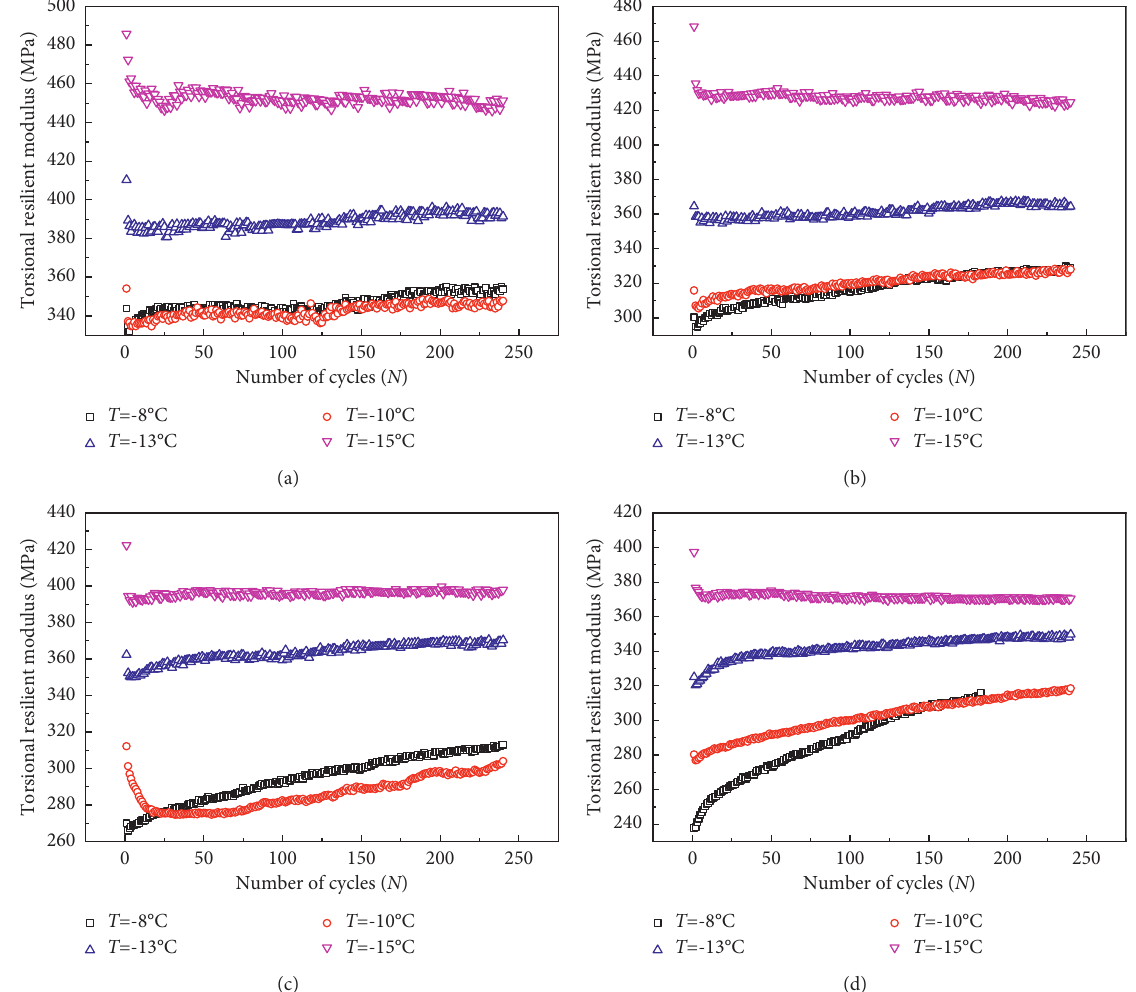
Figure 15: The evolution of the torsional resilient modulus versus the number of cycles at different temperatures and CSRs. (a) CSR � 0.225. (b) CSR � 0.300. (c) CSR � 0.375. (d) CSR �